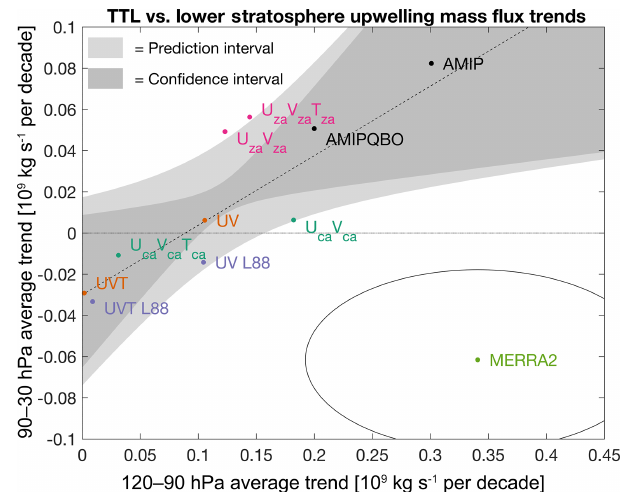
Figure 4. Tropical upwelling trends averaged over the lower strato- sphere versus upwelling trends averaged over the TTL. The regres- sion line, 95% confidence interval, and prediction interval are in- dicated by the dashed line, dark shading, and light shading, respec- tively. The circle around MERRA2 indicates the 95% confidence